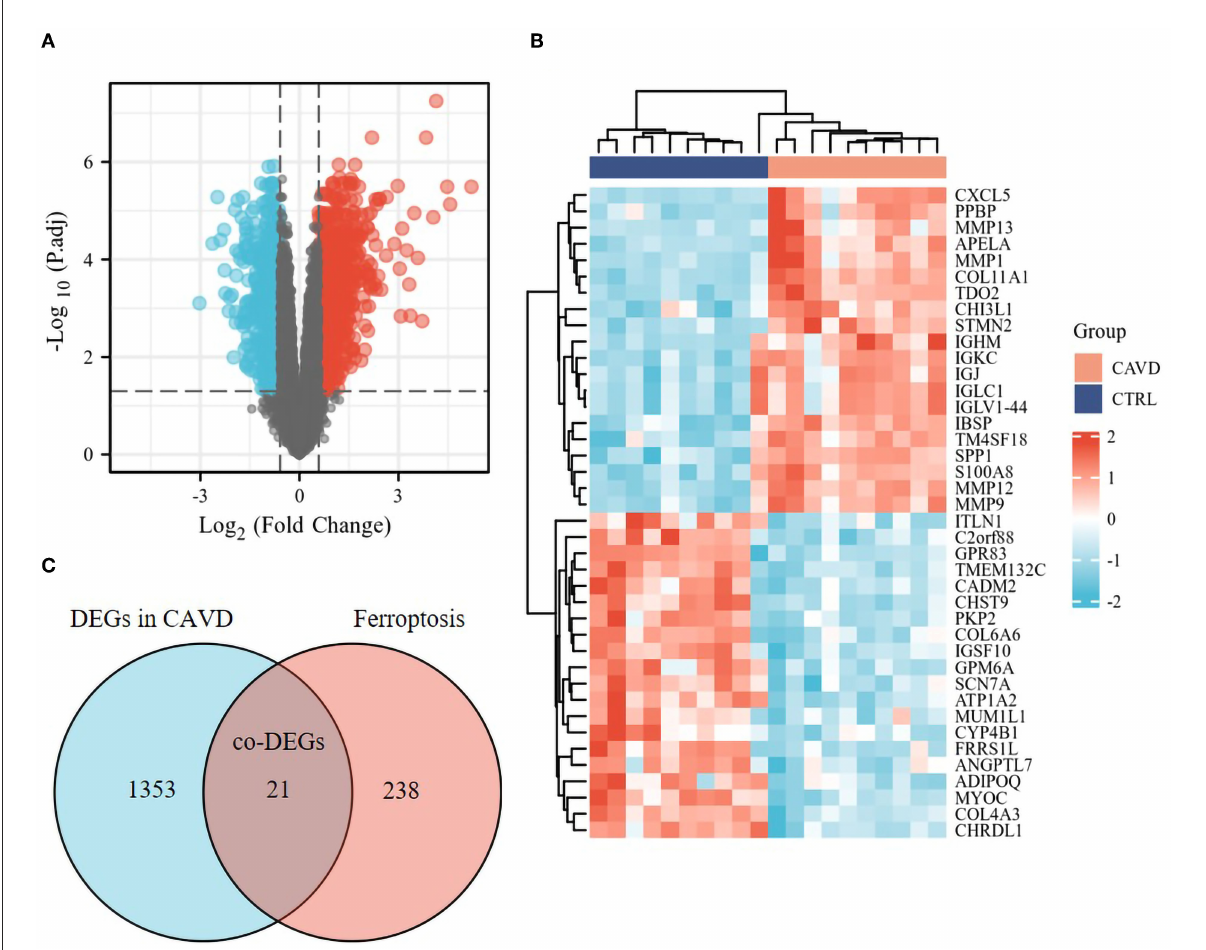
FIGURE1 Identification of the ferroptosis DEGs in CAVD. (A) Volcano plot of DEGs in CAVD. Volcano plots were drawn after the combination of GSE12644 and GSE51472 gene chips. 21,655 genes remained after removing the null ID value and 1,374 DEGs, including 795 upregulated (red dots) and 579 downregulated genes (blue dots), met the threshold set as fold change > 1.5 and adjusted p -value < 0.05 in CAVD. (B) Heatmap of DEGs in CAVD. Heatmap shown the upregulated (red, positive value) and downregulated (blue, negative value) top 20 DEGs in these samples. (C) Venn diagrams of the ferroptosis DEGs. Venn diagram indicated 21 co-DEGs (i.e., ferroptosis DEGs) from the intersection of the ferroptosis dataset (259 genes) with DEGs in CAVD